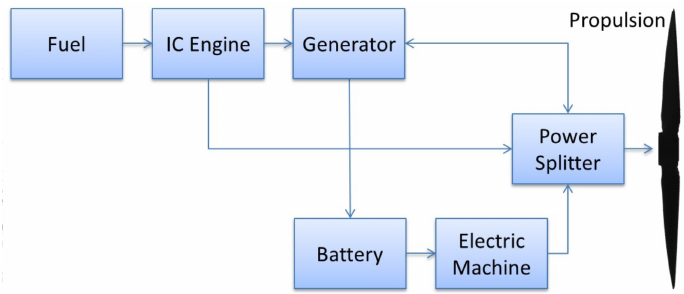
Figure 7. Series/parallel or power-split configuration energy flow